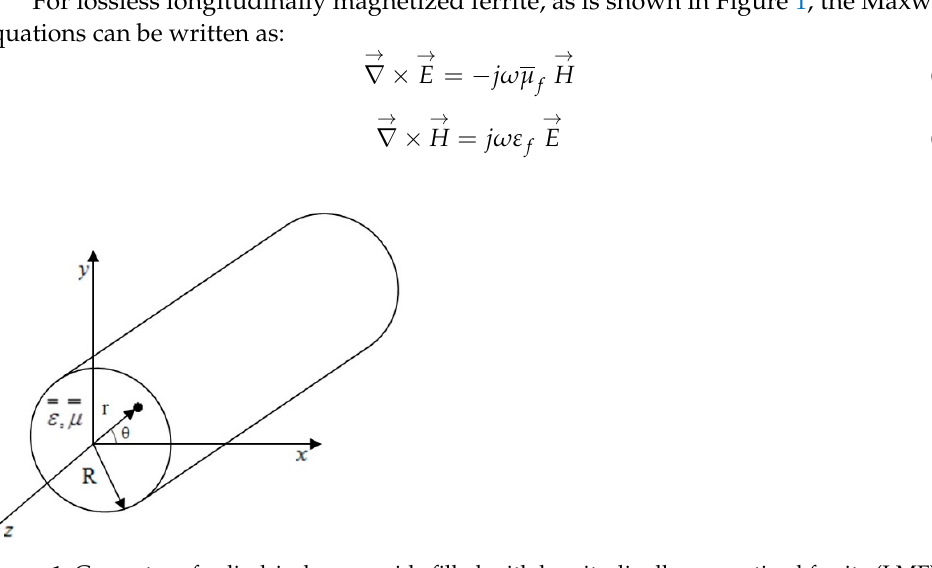
Figure 1. Geometry of cylindrical waveguide filled with longitudinally magnetized ferrite (LMF).